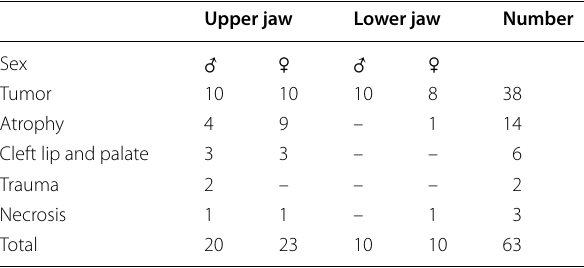
Table 1 Distribution of the cases according to sex and indications